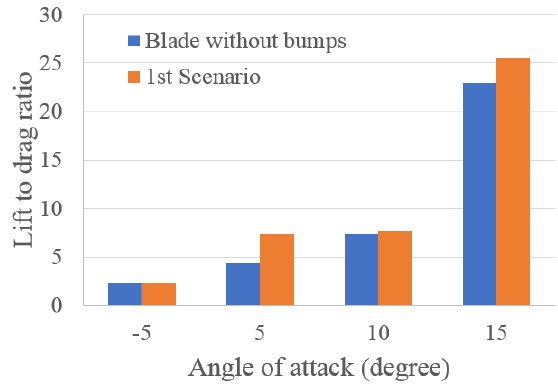
Figure 11. Influences of the bumps on F L / F D at different angles of attack.